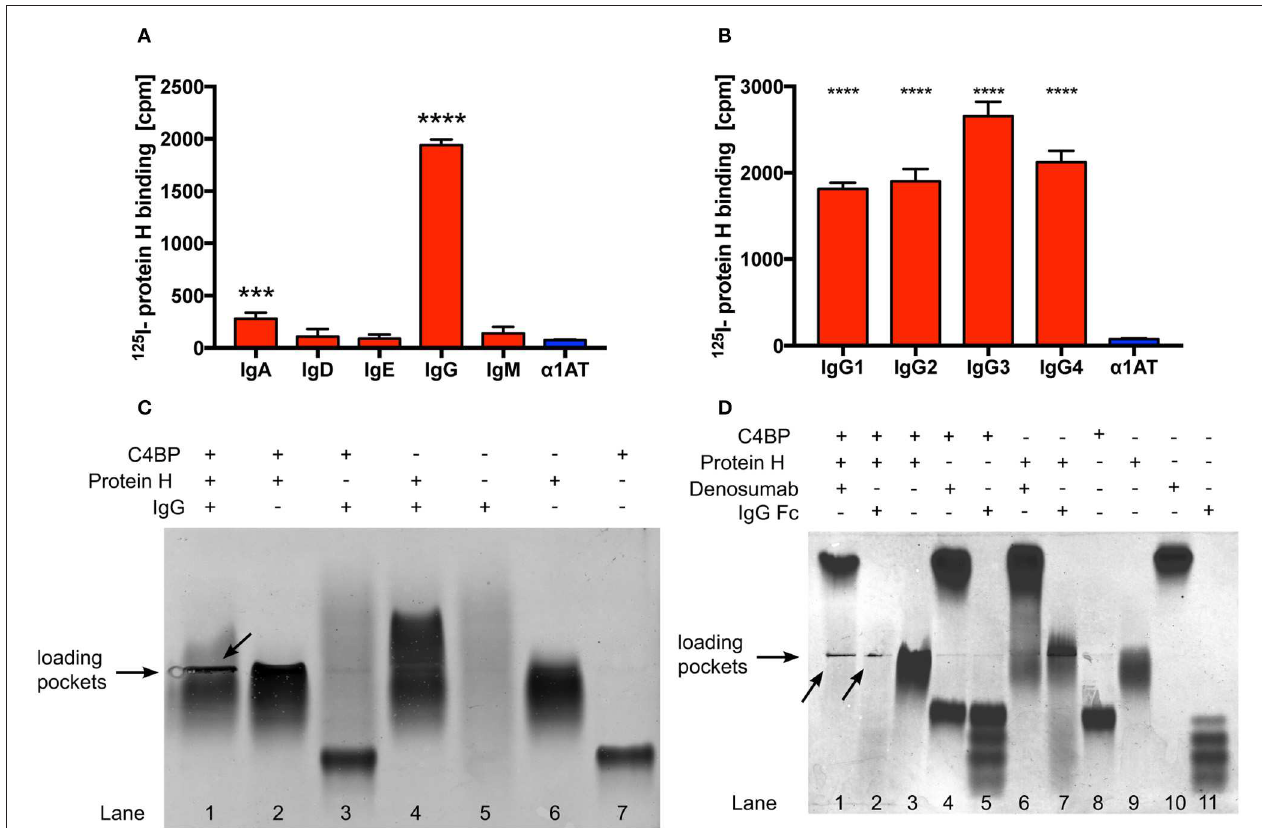
FIGURE 1 | Protein H binds human IgG and C4BP. Protein H binds to IgG and to a minor extent also IgA, but not other classes of immunoglobulins (A) . All four tested subclasses of human IgG bind Protein H in a similar manner with a preference for IgG3 (B) . Protein H, C4BP and IgG, alone or in combinations (C) , as well as Denosumab and IgG-Fc together with C4BP and Protein H (D) were separated on a native horizontal agarose gel and stained with Coomassie blue. Arrows indicate protein complexes which did not migrate. The mean (SD) of three separate experiments is shown in (A) and (B) . One representative experiment of at least three repeats is shown in (C) and (D) . *** p < 0.001 and **** p < 0.0001 assessed by 1-way ANOVA (A) and (B) with Bonferroni’s post-test compared to α 1 anti-trypsin ( α 1AT), an irrelevant protein